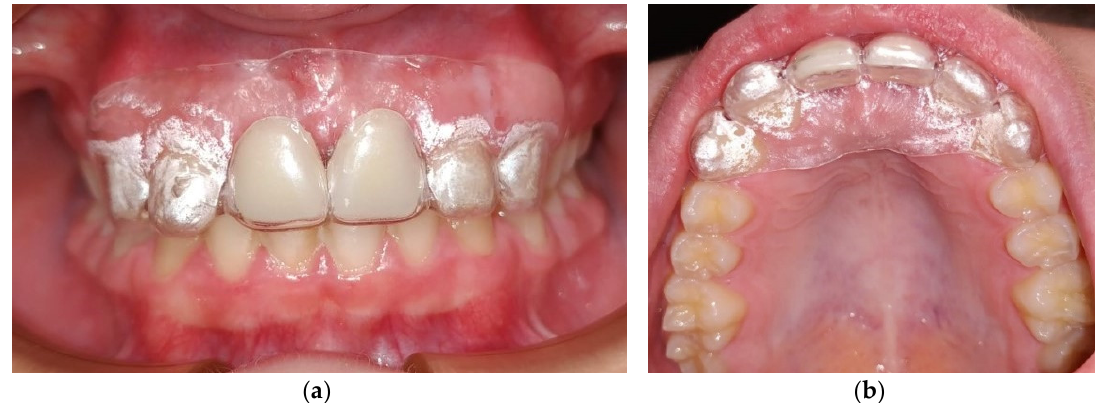
Figure 4. Trumpet edentulous anterior tooth appliance: ( a ) Front view; ( b ) Palatal view with the EVA material design and retention on the adjacent teeth.